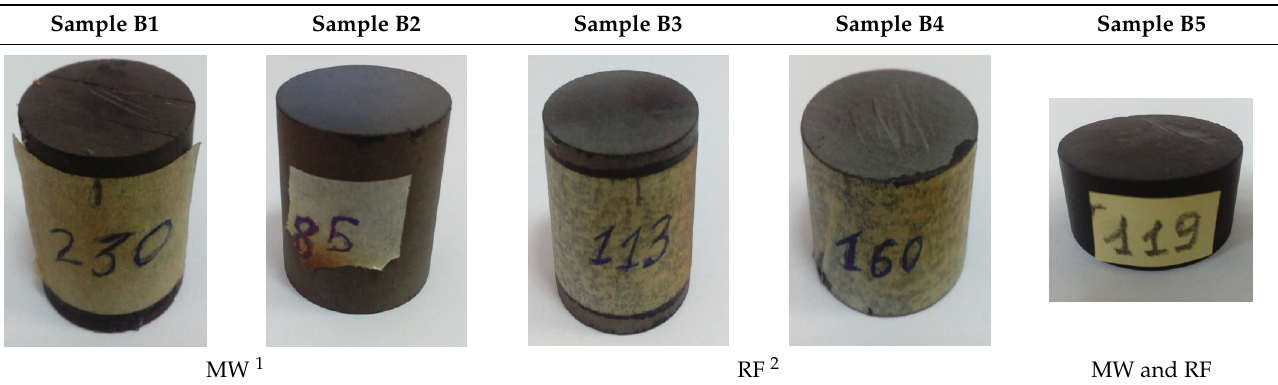
Table 1. The photos of the Bazhenov Formation samples and type of the electromagnetic treatment exposed in the experiments.